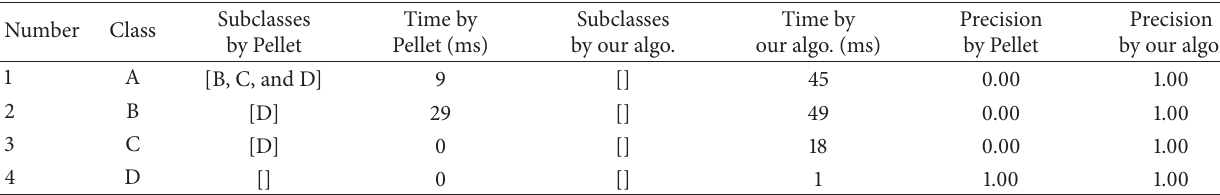
Table 4: Calculating list of sub classes: case2.